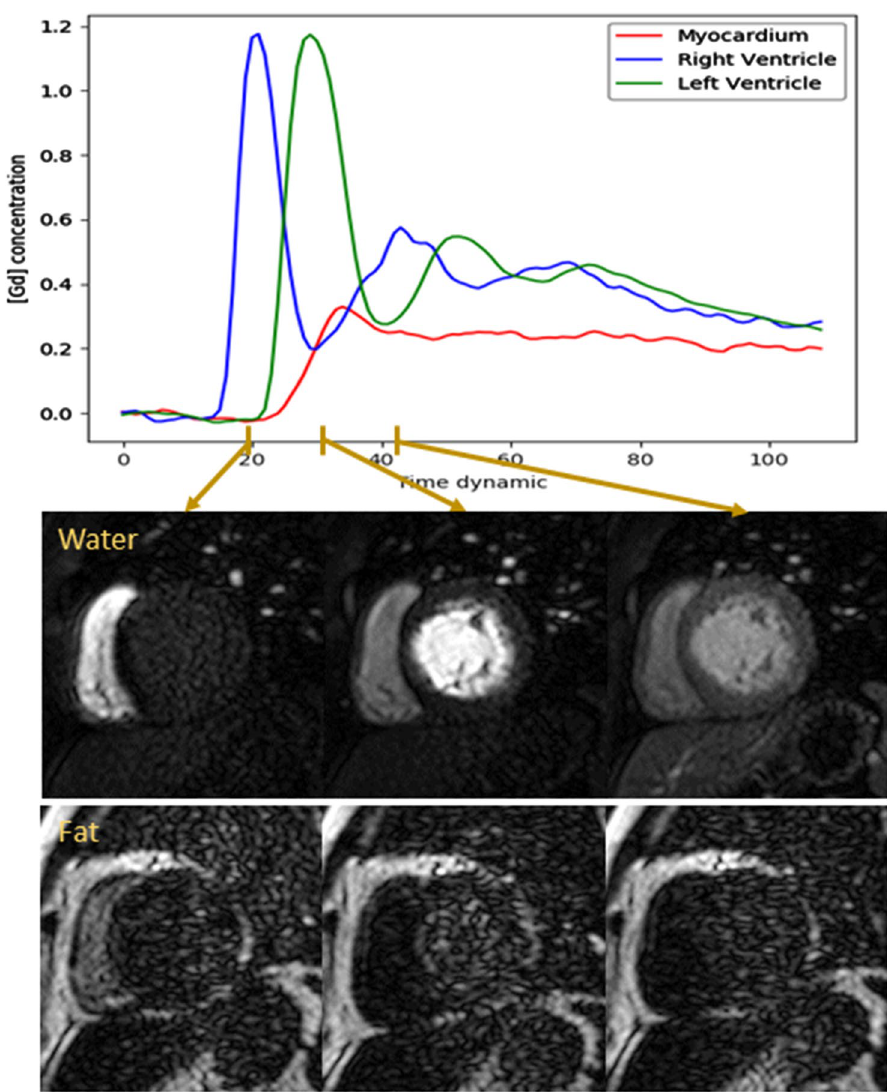
3), peak enhancement in the left ventricle (divided by 3) and peak myocardial enhancement). The fat images are free of the dynamic contrast-enhancement that precludes image registration, while retaining enough structural information to allow rigid correction of the respiratory